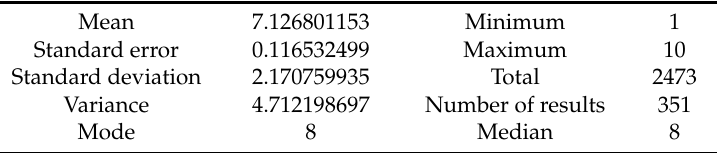
Table 6. Results of the accuracy